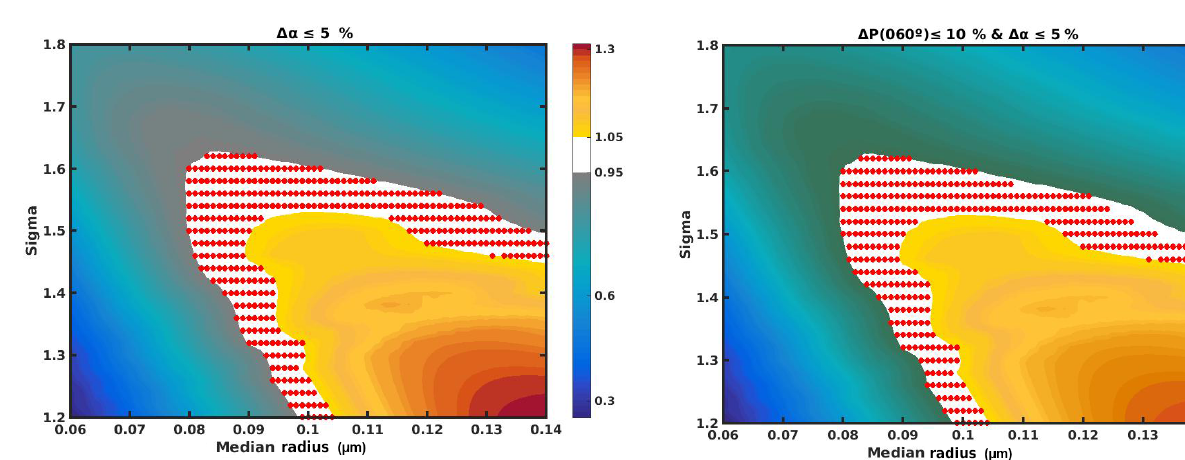
Figure 21. The background contour plot is the same as in Fig. 20. This time, red circles appear only for cases in which the Ångström coefficient ratio is within ± 5% of 1 and the aerosol phase func- tion is within ± 10% of the V1 aerosol size distribution value at (cid:50) = 60 ◦ . Nearly every aerosol size distribution that satisfies the Ångström coefficient ratio criterion also satisfies the aerosol phase function criterion for this case.